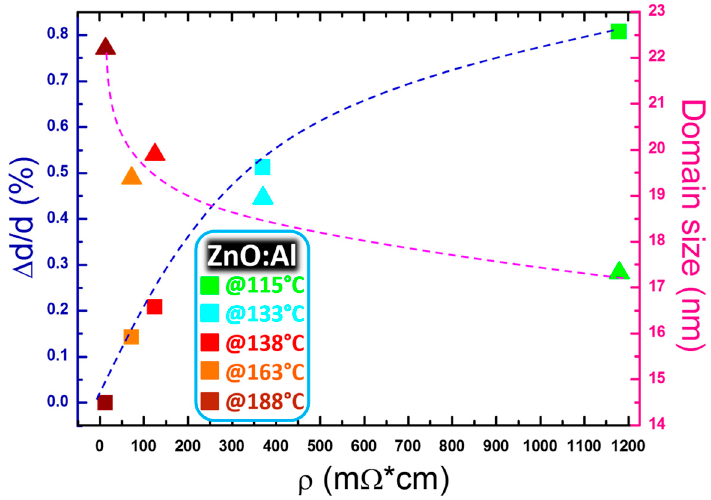
Figure 7. Structural properties evaluated by XRD analysis correlated to the electrical behavior of the AZO layers. On the left side (blue curve): strain along the c-axis; on the right side (pink curve): crystallographic domain size. The different colors of the data points correspond to different deposition temperatures.